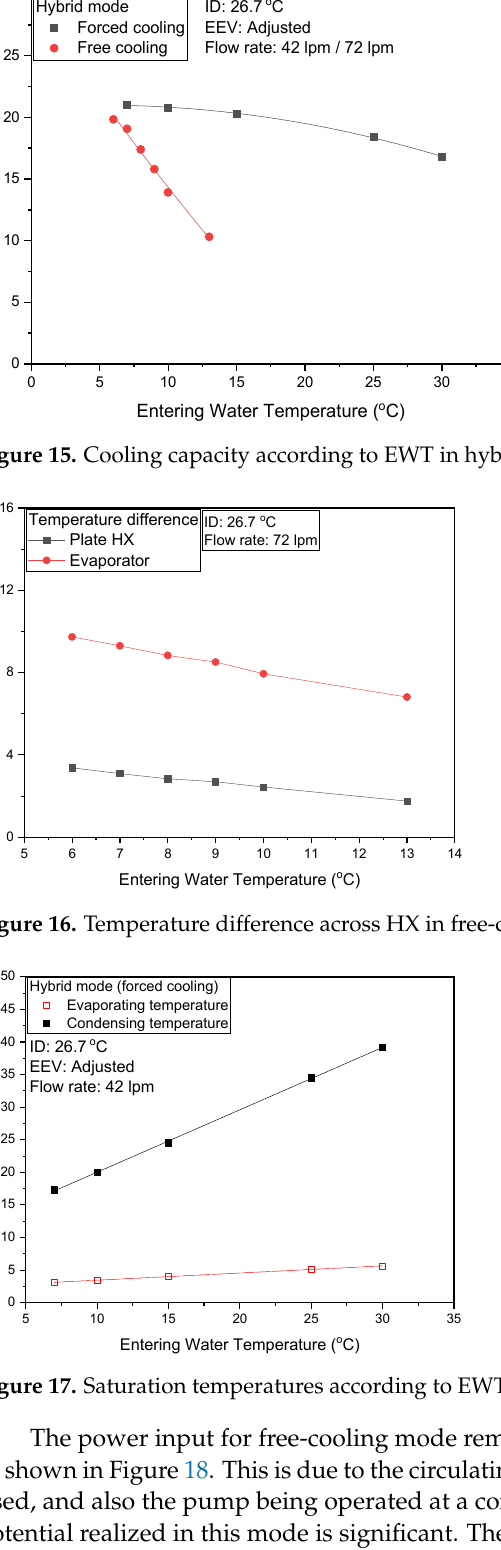
Figure 14. COP according to secondary fluid flow rate and OD air variation.